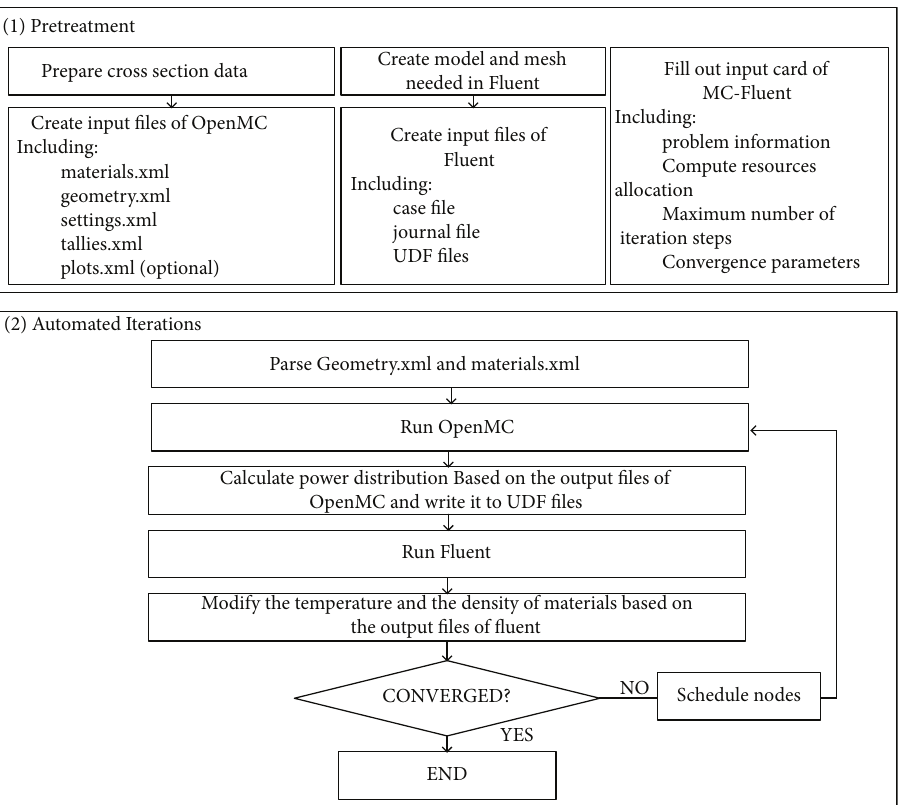
Figure 1: The procedure of MC-FLUENT with block Gauss–Seidel-type Picard